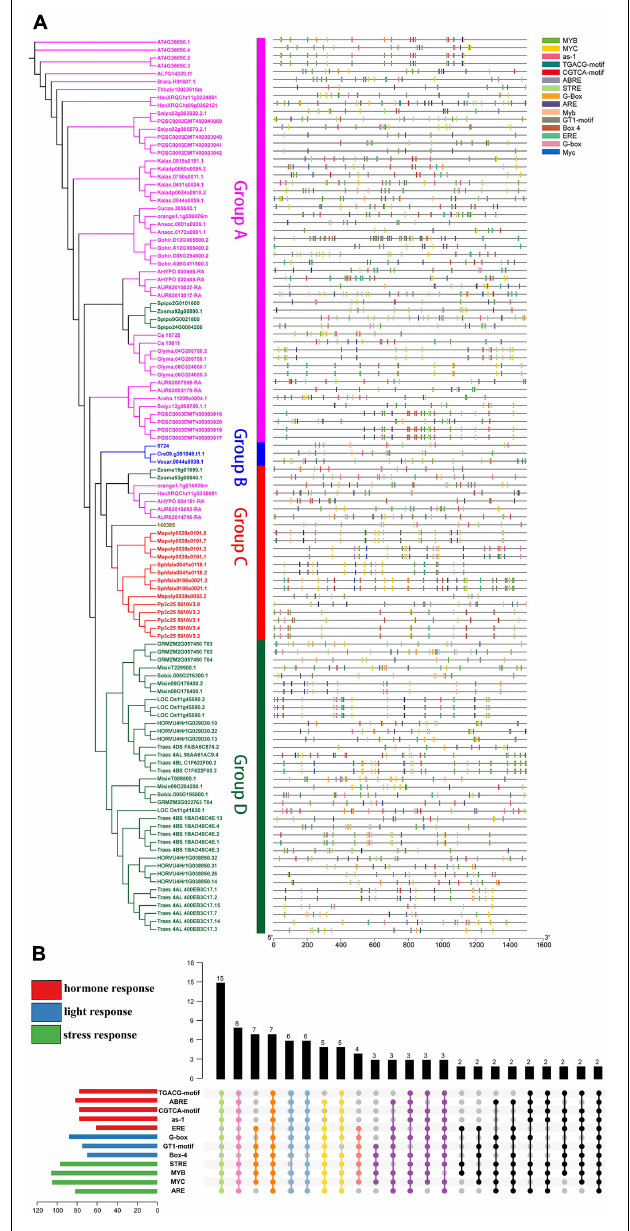
FIGURE 5 | Putative motifs in the promoter regions of plant U2AF65A genes. (A) Motifs are represented by rectangles of various colors. These cis -acting motifs of each plant U2AF65A gene are labeled along the 1.5-kb promoter region (straight line) according to their relative nucleotide positions to the transcript start site. (B) Specific enrichment statistics of the motifs in response to stress, hormones, and